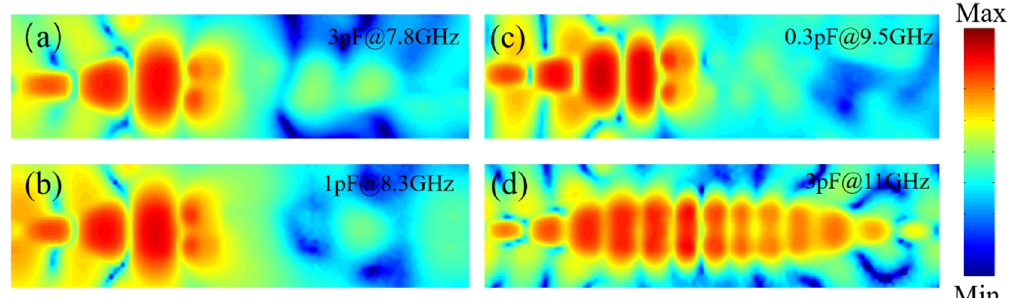
Figure 7. The measured near-field distribution of the device at ( a ) 7.8 GHz with capacitance 3 pF, ( b ) 8.3 GHz with capacitance 1 pF, ( c ) 9.5 GHz with capacitance 0.3 pF, ( d ) 11 GHz with capacitance 0.3 pF.